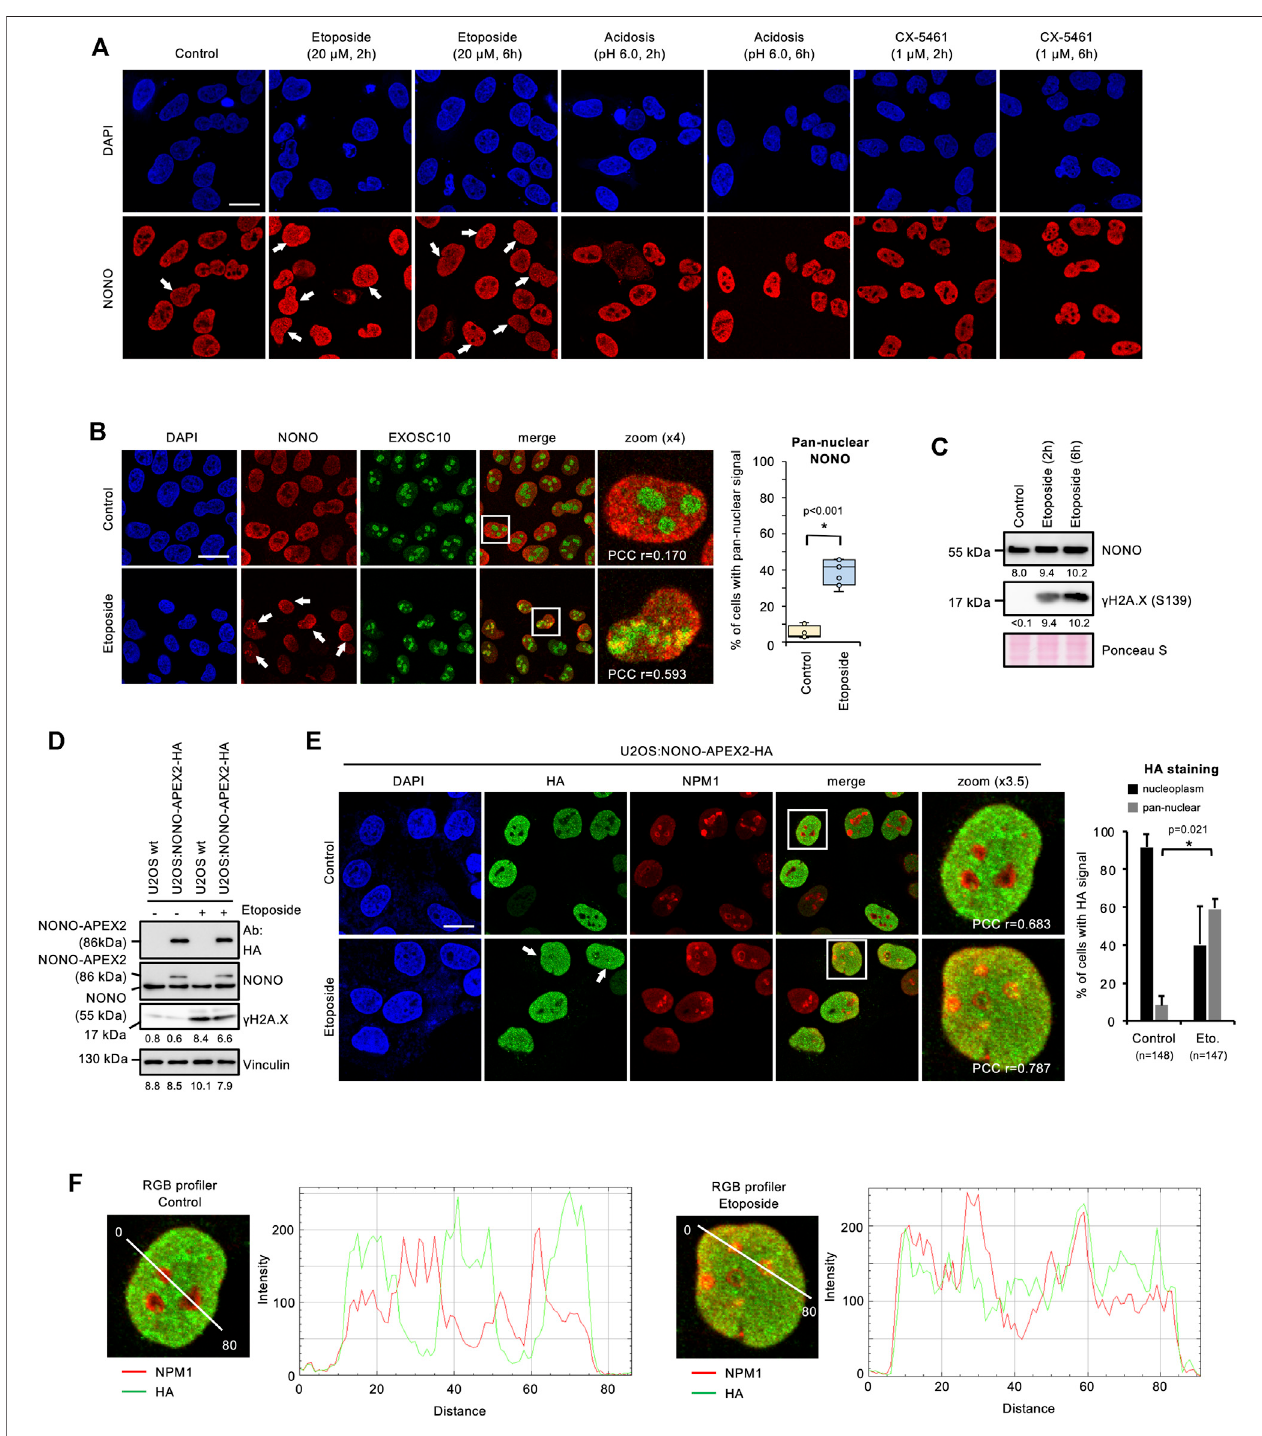
FIGURE 2 | Accumulation of NONO and NONO-APEX2-HA in the nucleolus in response to DNA damage in U2OS cells. (A) Confocal imaging of NONO in unperturbed cells (control) or upon incubation with Etoposide, acetic acid (acidosis), or RNA polymerase I inhibitor (CX-5461). (B) Confocal imaging of NONO and exosomal subunit EXOSC10 with or without (+/-) Etoposide (20 μ M, 2 h) (left). Quantitation of cells with pan-nuclear NONO staining (right). (C) Immunoblots detecting NONO and Ser139-phosphorylated histone variant H2A.X ( γ H2A.X) +/- Etoposide (20 μ M, 2 h). (D) Immunoblots detecting NONO-APEX2-HA, NONO and γ H2A.X ± Etoposide(20 μ M,2 h).Immunoblotswerequanti fi edbyImageJ.Signalsareshownasarbitraryunits.wt,wildtype;Vinculin,PonceauS,loadingcontrols;Ab, antibody. (E) Confocal imaging of NONO-APEX2-HA and NPM1 ± Etoposide (20 μ M, 2 h) (left). Quantitation of cells with nucleoplasmic and pan-nuclear HA staining (right). (F) RGB pro fi lerplots forzoomed panels from (E) . Representative cellsare shown. DAPI, 4 ‘ ,6-diamidino-2-phenylindol;scale bar, 10 μ m; whiteboxes, magni fi ed areas; white arrowheads, pan-nuclear NONO staining; asterisk, p < 0.001 (Student ’ s t-test); n.s., not signi fi cant; r = Pearson ’ s correlation coef fi cient (PCC).